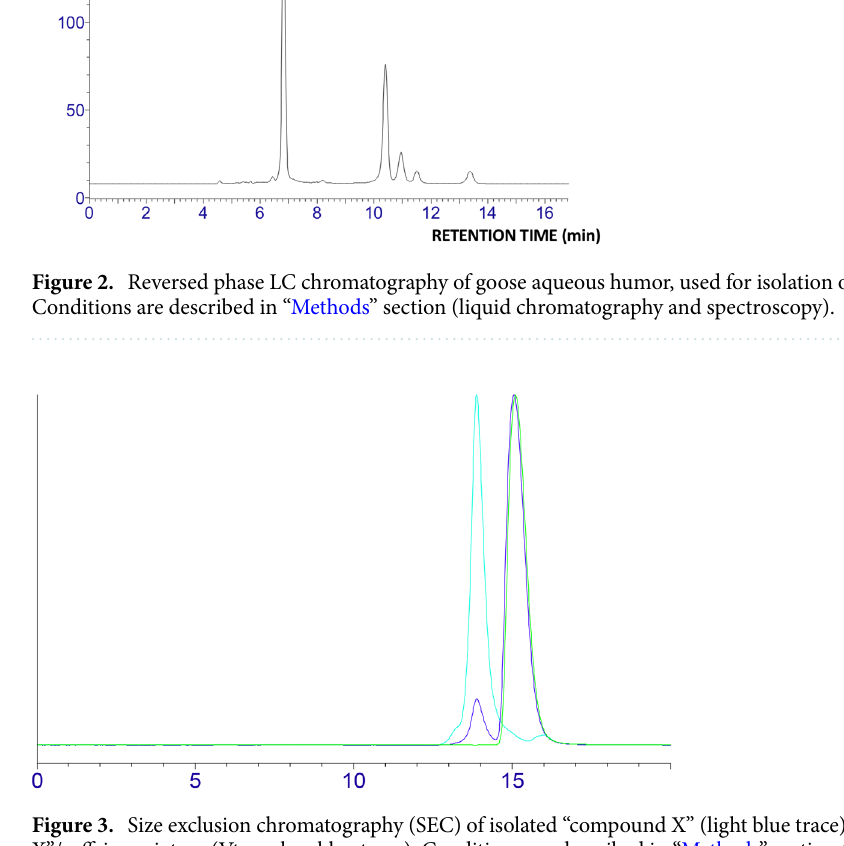
Figure 3. Size exclusion chromatography (SEC) of isolated “compound X” (light blue trace) and “compound X”/caffeine mixture (Vt marker, blue trace). Conditions are described in “Methods” section (liquid chromatography and